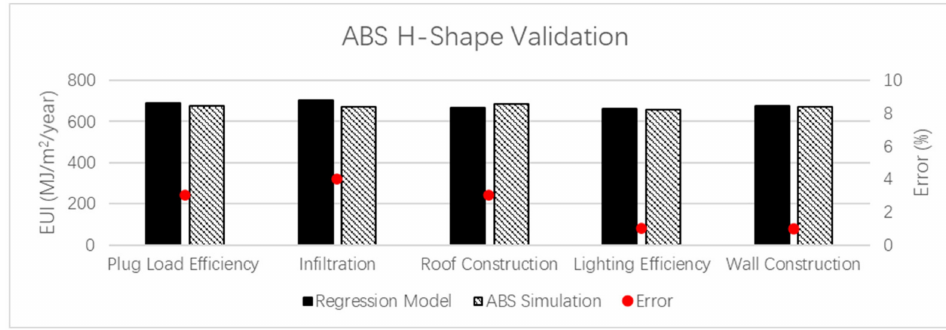
Figure 10. ABS Case study validation—H shape.